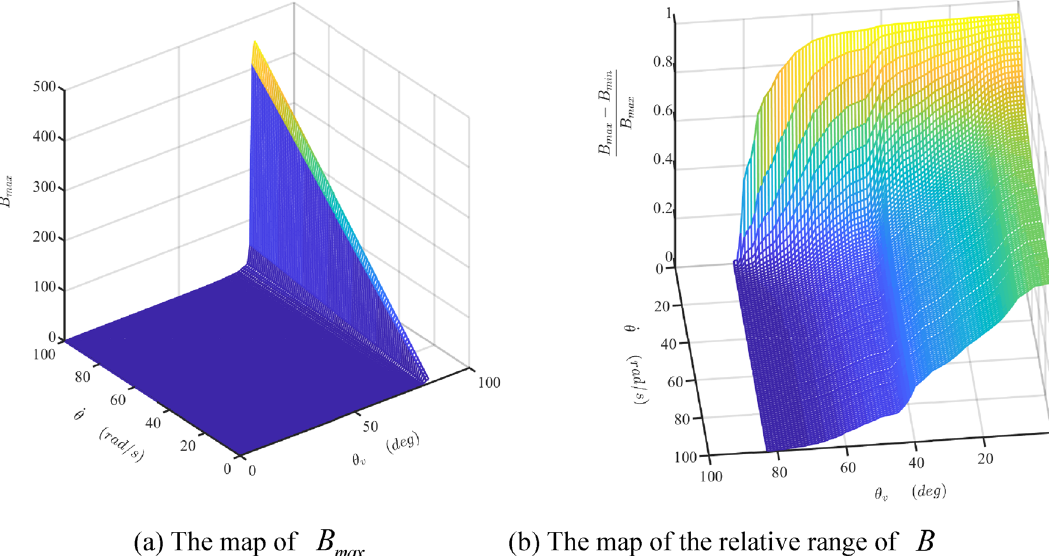
Figure 17. The maps of the maximum value and the relative range of the damper coefficient B . (Matlab2019a. https:// ww2. mathw orks. cn/ produ cts/ get- matlab. html?s_ tid= gn_